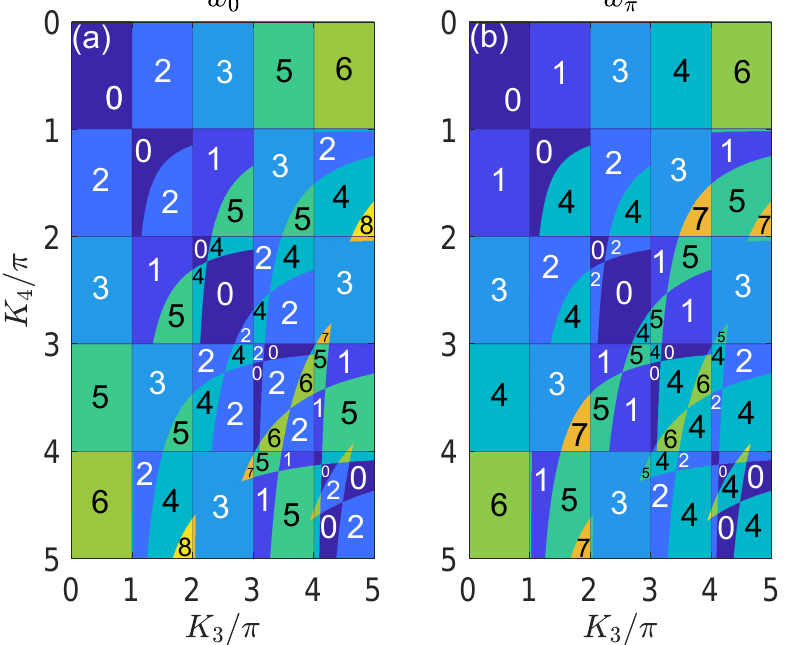
Figure 2. Topological phase diagram of the 2D on-resonance double-kicked lattice with respect to the kicking strengths K 3 and K 4 . The other system parameters are set as ( K 1 , K 2 ) = ( 0.5 π ,3.5 π ) . Different Floquet HOTPs are distinguished by different colors in both figure panels. The values of w 0 and w π for each topological phase are obtained from Equations (33) and (34), which are presented explicitly in figure panels ( a ) and ( b ),